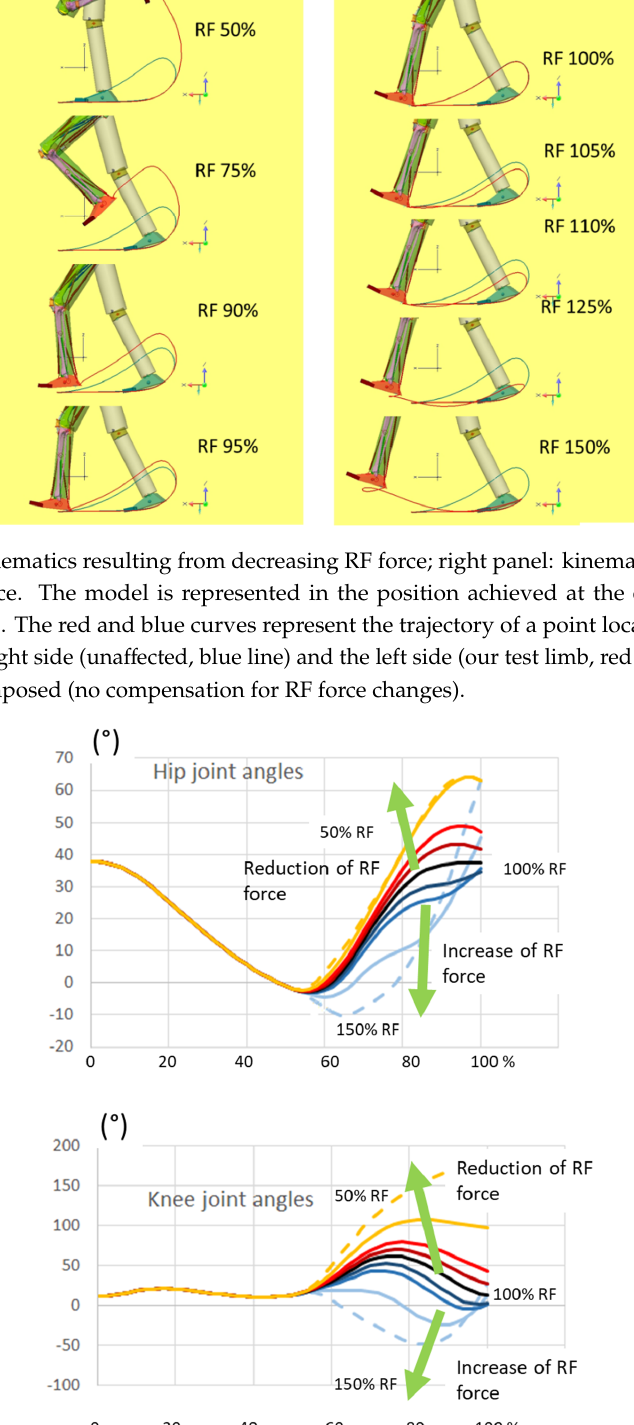
Figure 6. Changes of the hip and knee joint angles with increasing and decreasing RF force. The kinematics of the hip and knee were not imposed and resulted from the application of the RF force plus the residual moments (see